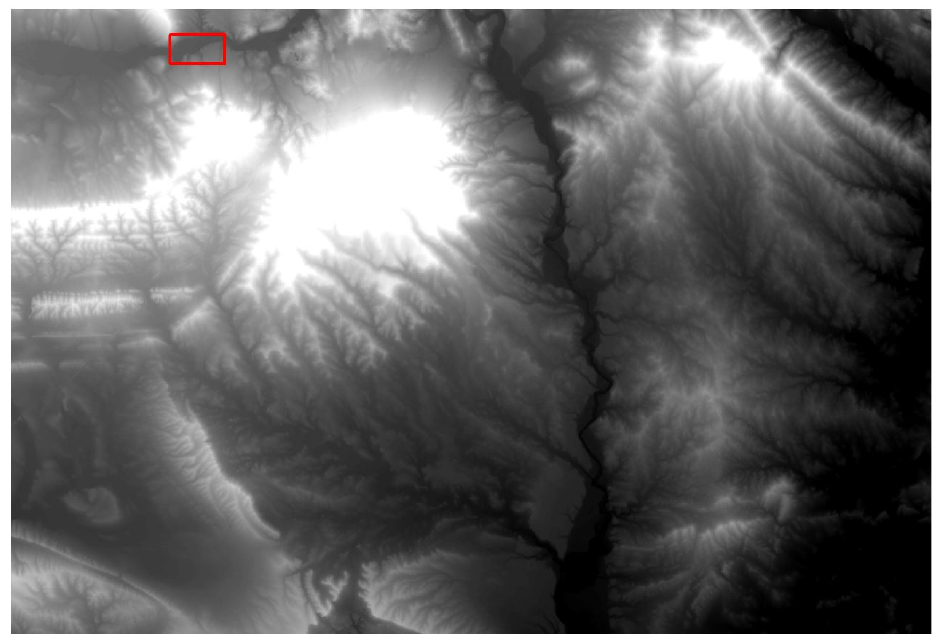
Figure 1. DEM over the study area (Allo, Navarra, Spain). Elevation range: [315, 1046] m.